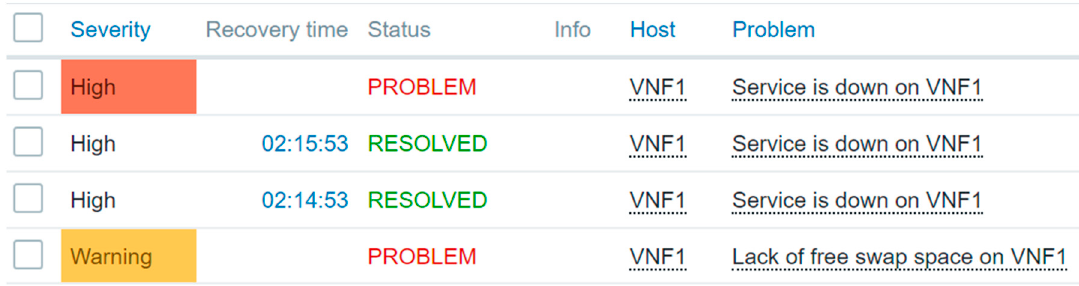
Figure 11. Monitoring result on the monitoring server.